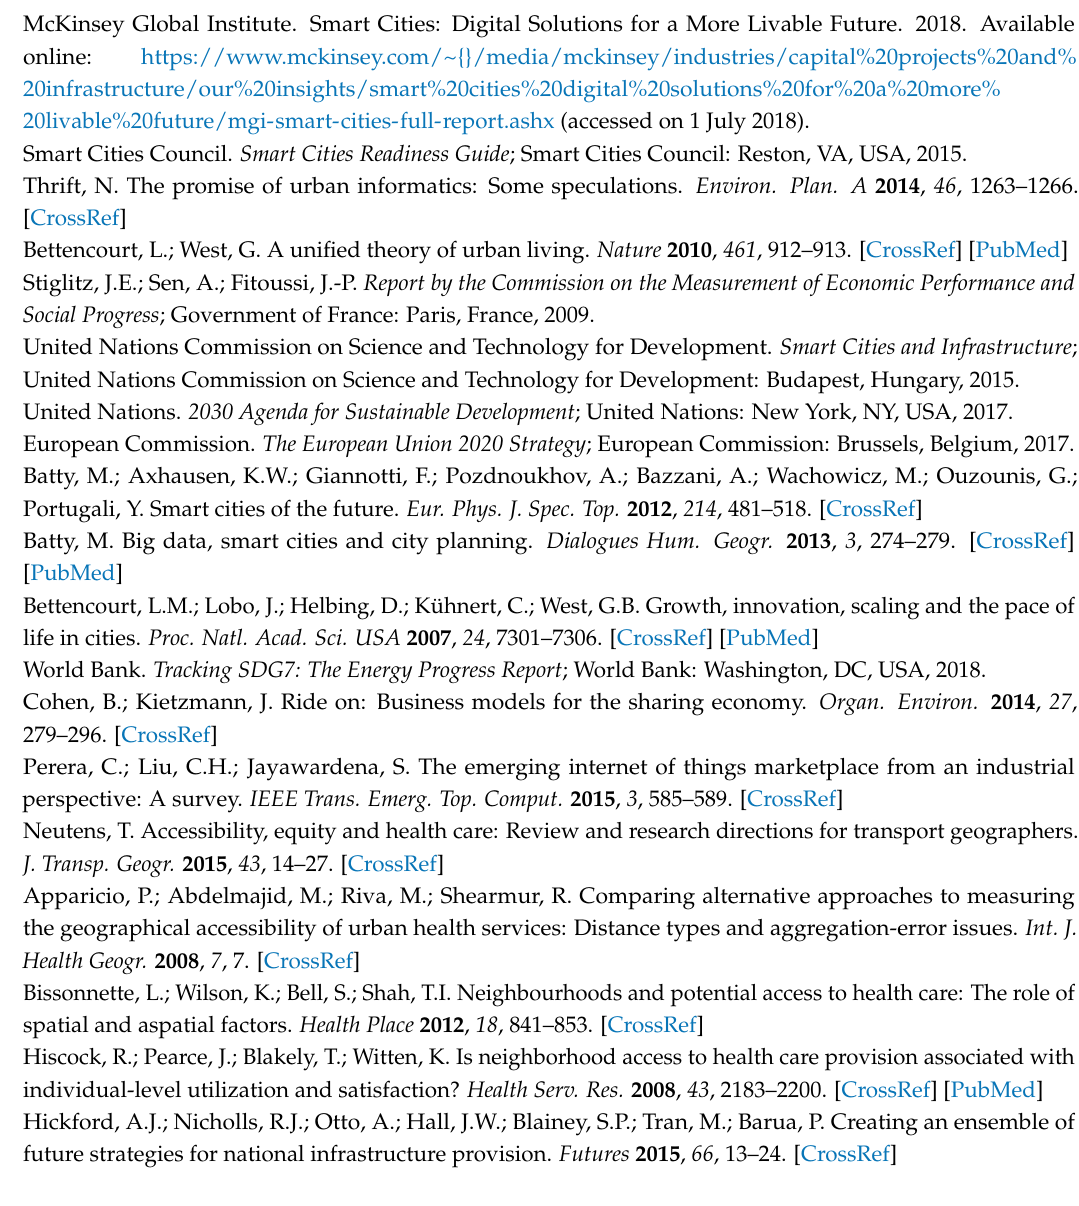
Figure S1: Spatial distribution of principal components; Figure S2: Spatially mapped SOM topology, coloured according to clustering; Figure S3: Spatially mapped SOM topology; Figure S4: Cumulative frequency distributions of travel-time to closest facility for each cell; Figure S5: Comparison of cluster results when using k-means clustering and hierarchical